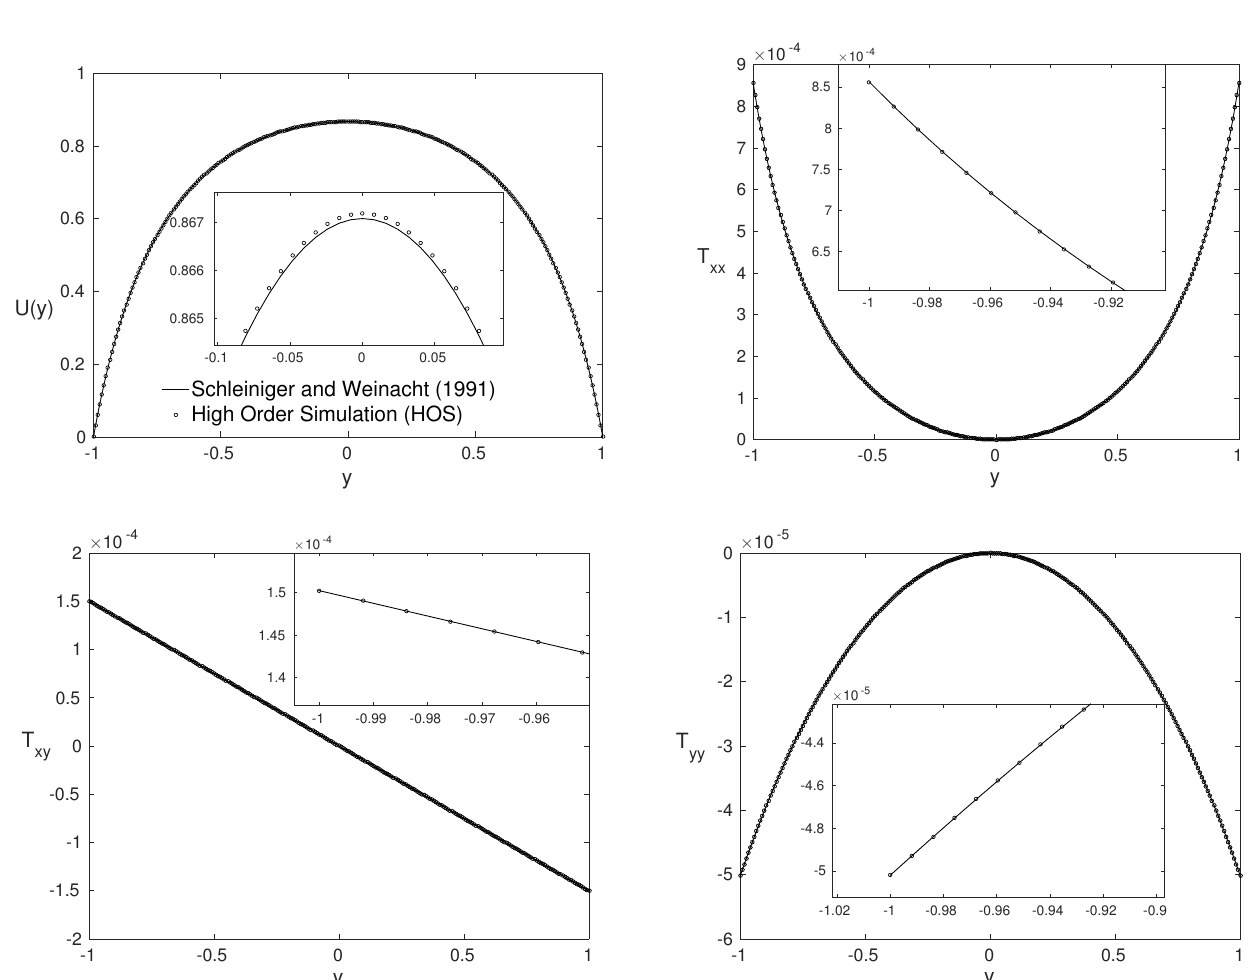
Figure 5. Same as in Figure 1 for dimensionless numbers: Re = 5000, β = 0, α G = 0.2 and Wi = 2.